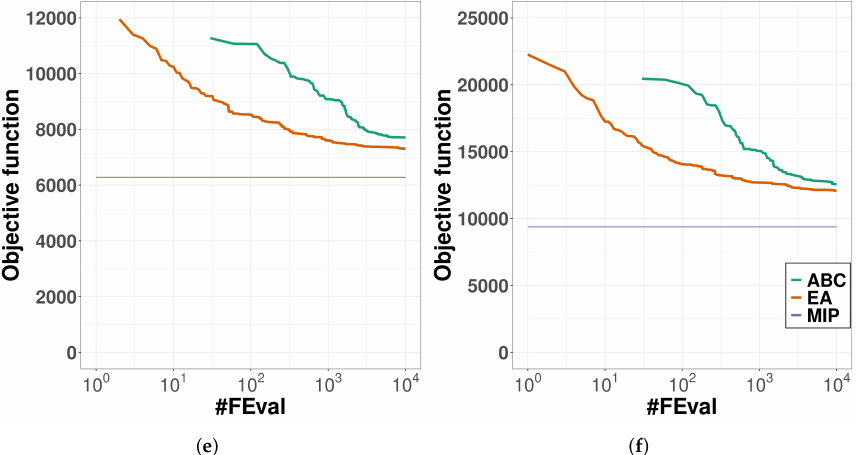
Figure 1. Convergence curves plotted for the algorithms considered, for a logistic network of different sizes, for the BLP model. Each curve is an average of 20 independent runs. ( a ) 5-node. ( b ) 10-node.